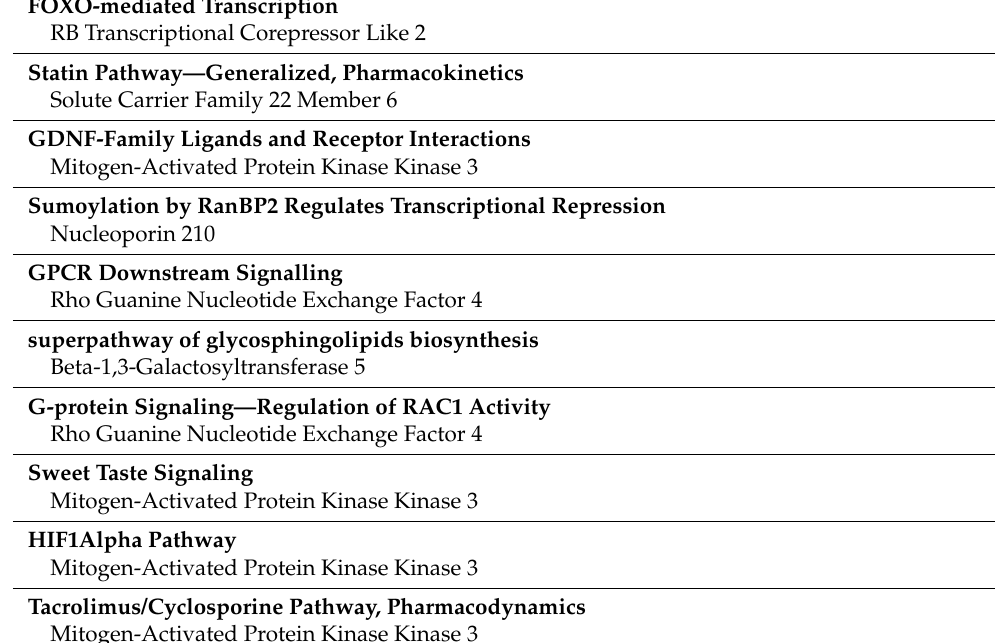
Table A2. Cont. FOXO-mediated Transcription RB Transcriptional Corepressor Like 2 Statin Pathway—Generalized,